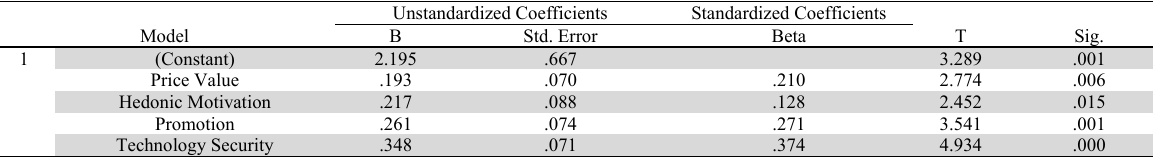
Result of Determination Coefficient Test